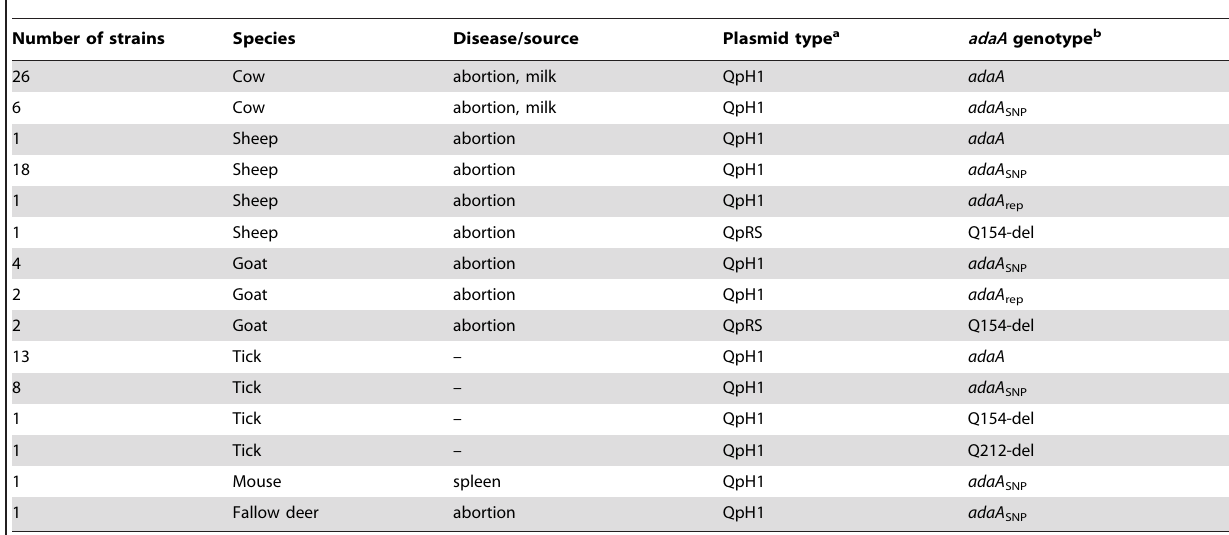
Table 2. adaA genotypes in 86 animal-derived Coxiella burnetii